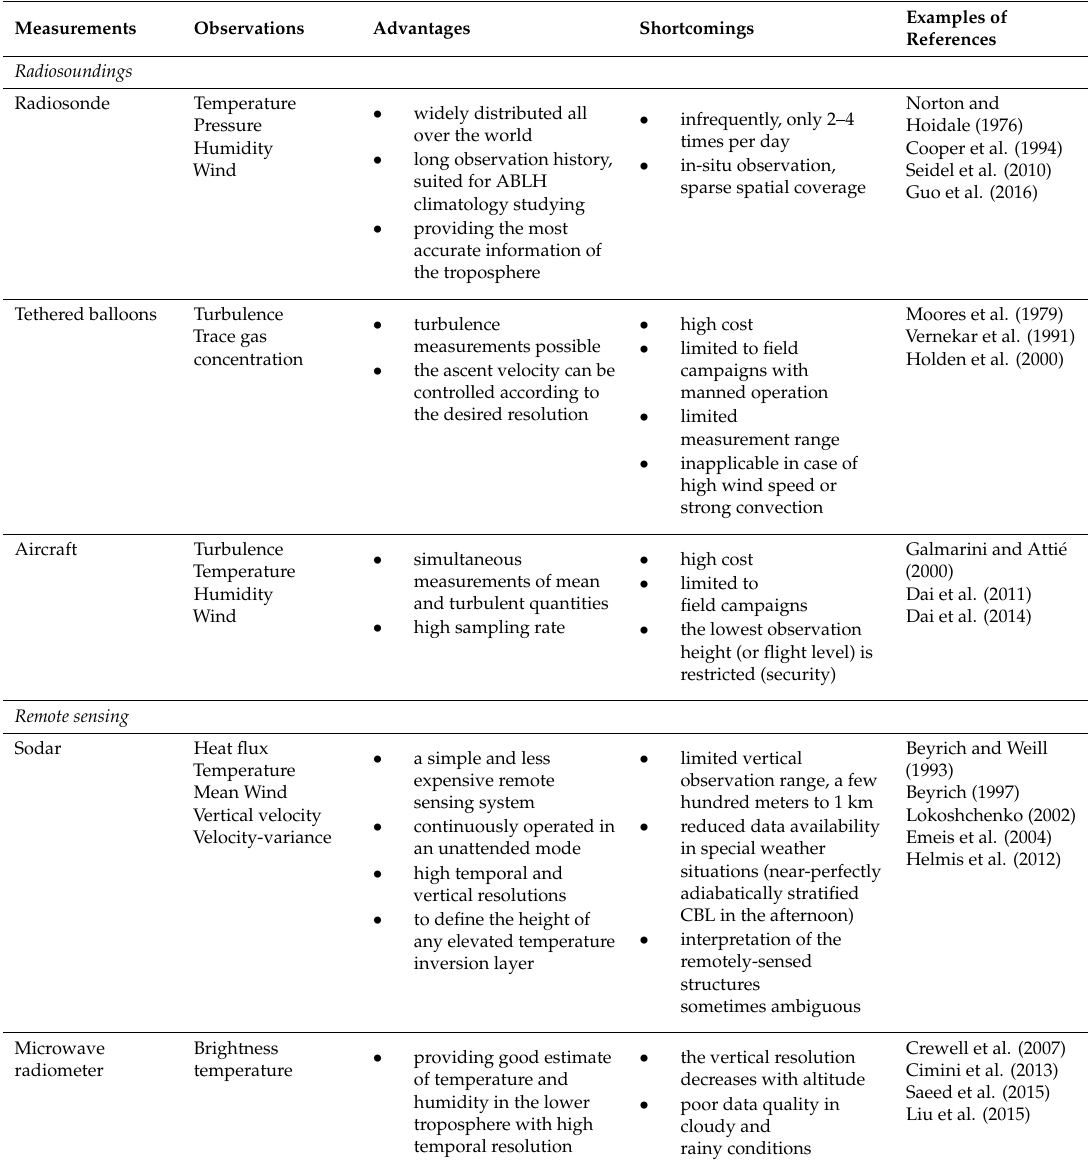
Table 1. Some Measurements for ABLH (ABLH, atmospheric boundary layer height; CBL, convective boundary layer; SNR, signal-to-noise